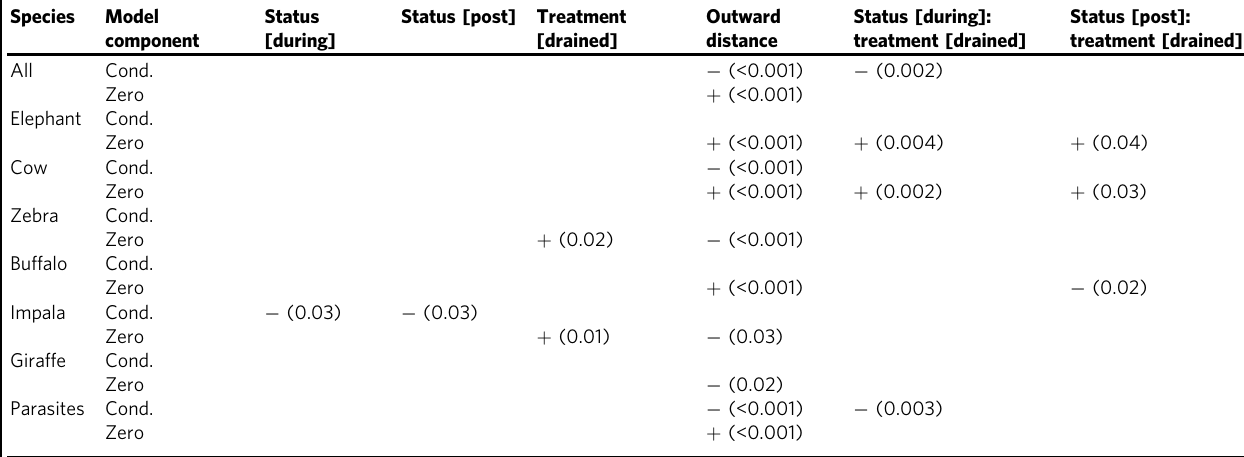
Table 1 Signi fi cant fi xed-effect coef fi cients for hurdle GLMM models of dung and parasite density for the experimental system are presented for both the conditional and zero-in fl ation components of the models ( “ Cond. ” , and “ Zero ” ). Species Model